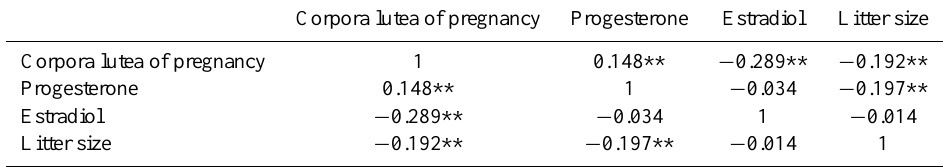
Table 1. The correlation of progesterone and estradiol secretion with the number of corpora lutea of pregnancy and litter size. Corpora lutea of pregnancy